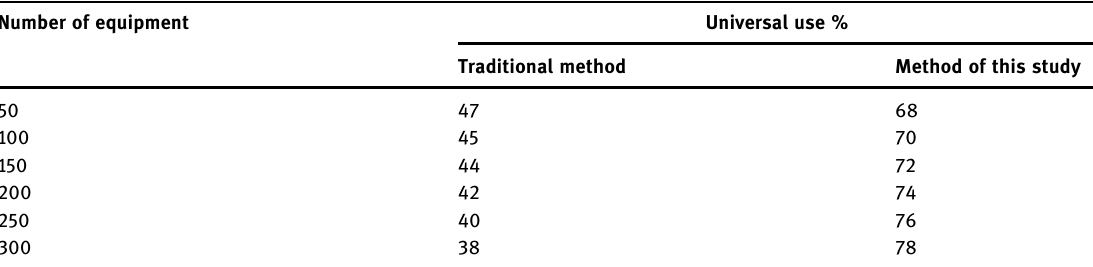
Table 3: Comparative analysis on loading e ff ect of railway fl atcars Number of